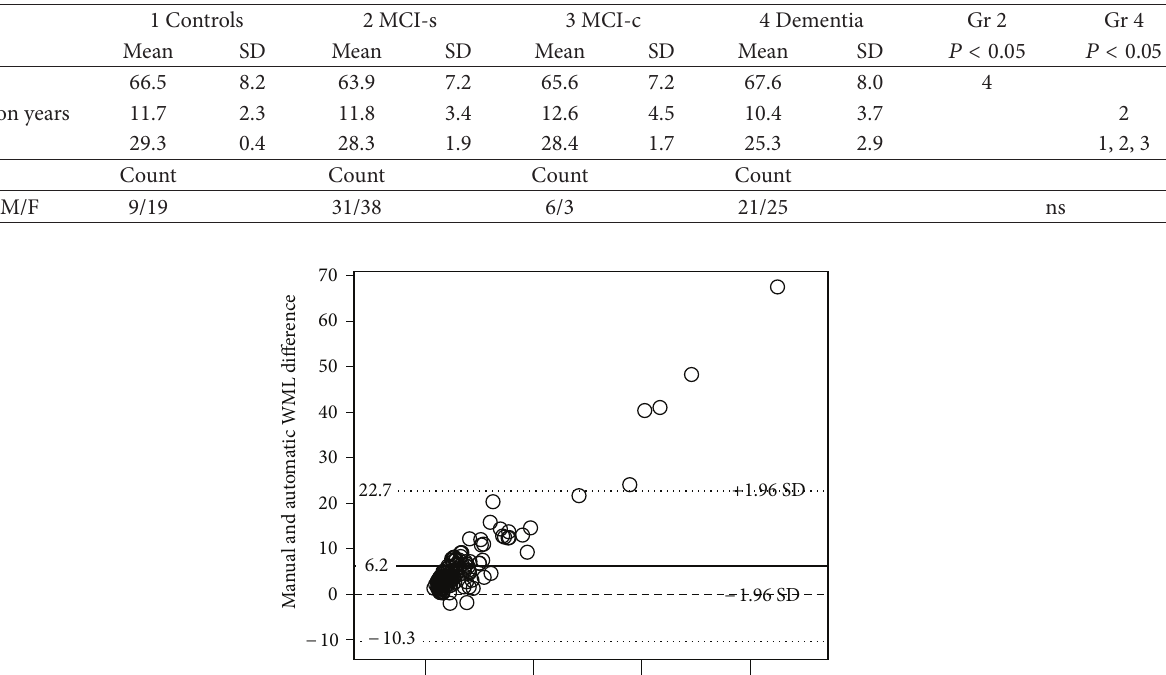
T 2: Study characteristics. -values were assessed by the two-tailed -test except gender where chi square was used. Gr 4 is group 4 Dementia. Gr 2 and MCI-s are stable MCI. MCI-c is converting MCI. Gr 2 and Gr 4 had signi�cantly lower scores than the group speci�ed in the cell for the pertaining variable; for example, Gr 2 (stable MCI) had signi�cantly lower age than group 4 (dementia group). ere was 𝑃𝑃 𝑡𝑡 no signi�cant difference in gender.